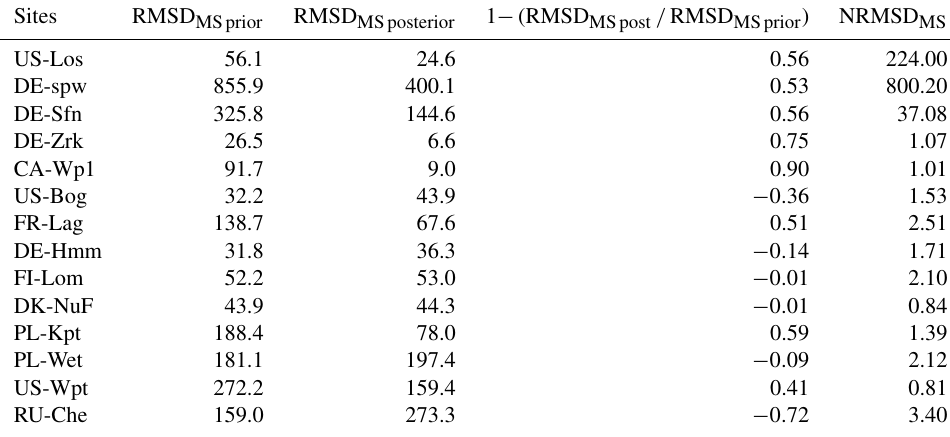
Table 7. Discrepancies between observed and simulated methane emissions are quantified by the root mean square difference (RMSD) approach. Minimization efficiency of the multi-site optimization is indicated by the relationship between the prior using average values of parameters optimized by the single site optimization and posterior RMSD MS as (1 − RMSD MSpost / RMSD MSprior ) × 100. Normalized root mean square difference (NRMSD MS ) is defined by the RMSD MS posterior normalized by the annual mean of observed methane emissions in Table